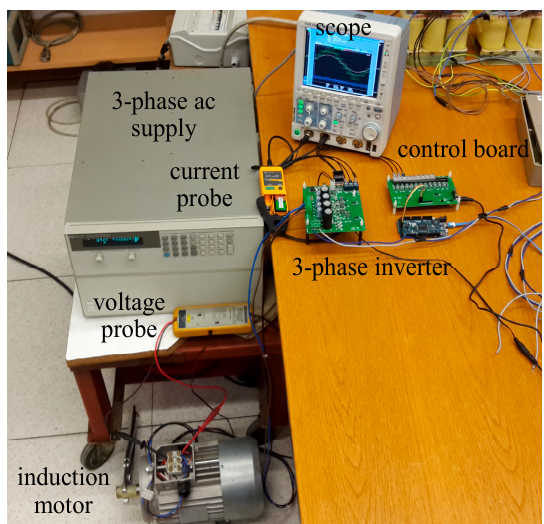
Figure 4. Experimental setup for measuring frequency dependence of L eq .